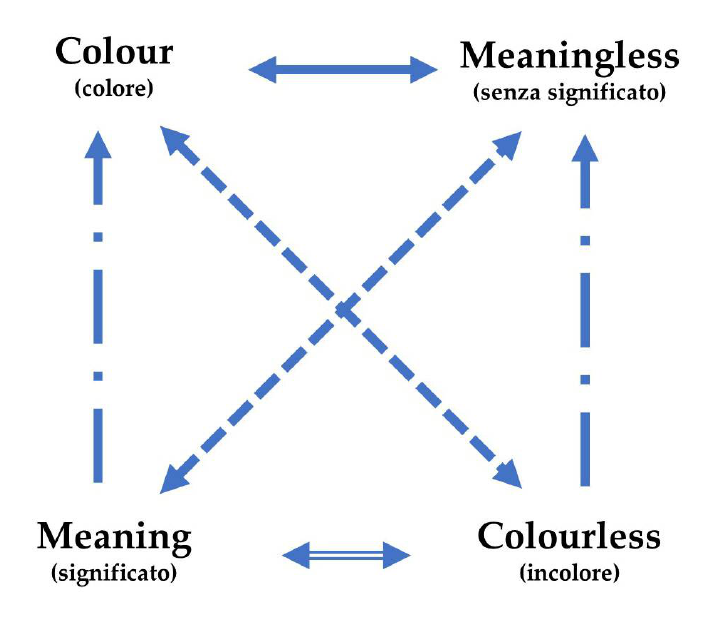
Figure 4. The Greimas semiotic square referred to the oppositional couple Colour/Colourless and Meaning/Meaningless with the identification of the complex term Colour / Meaningless in the Islamic Architecture